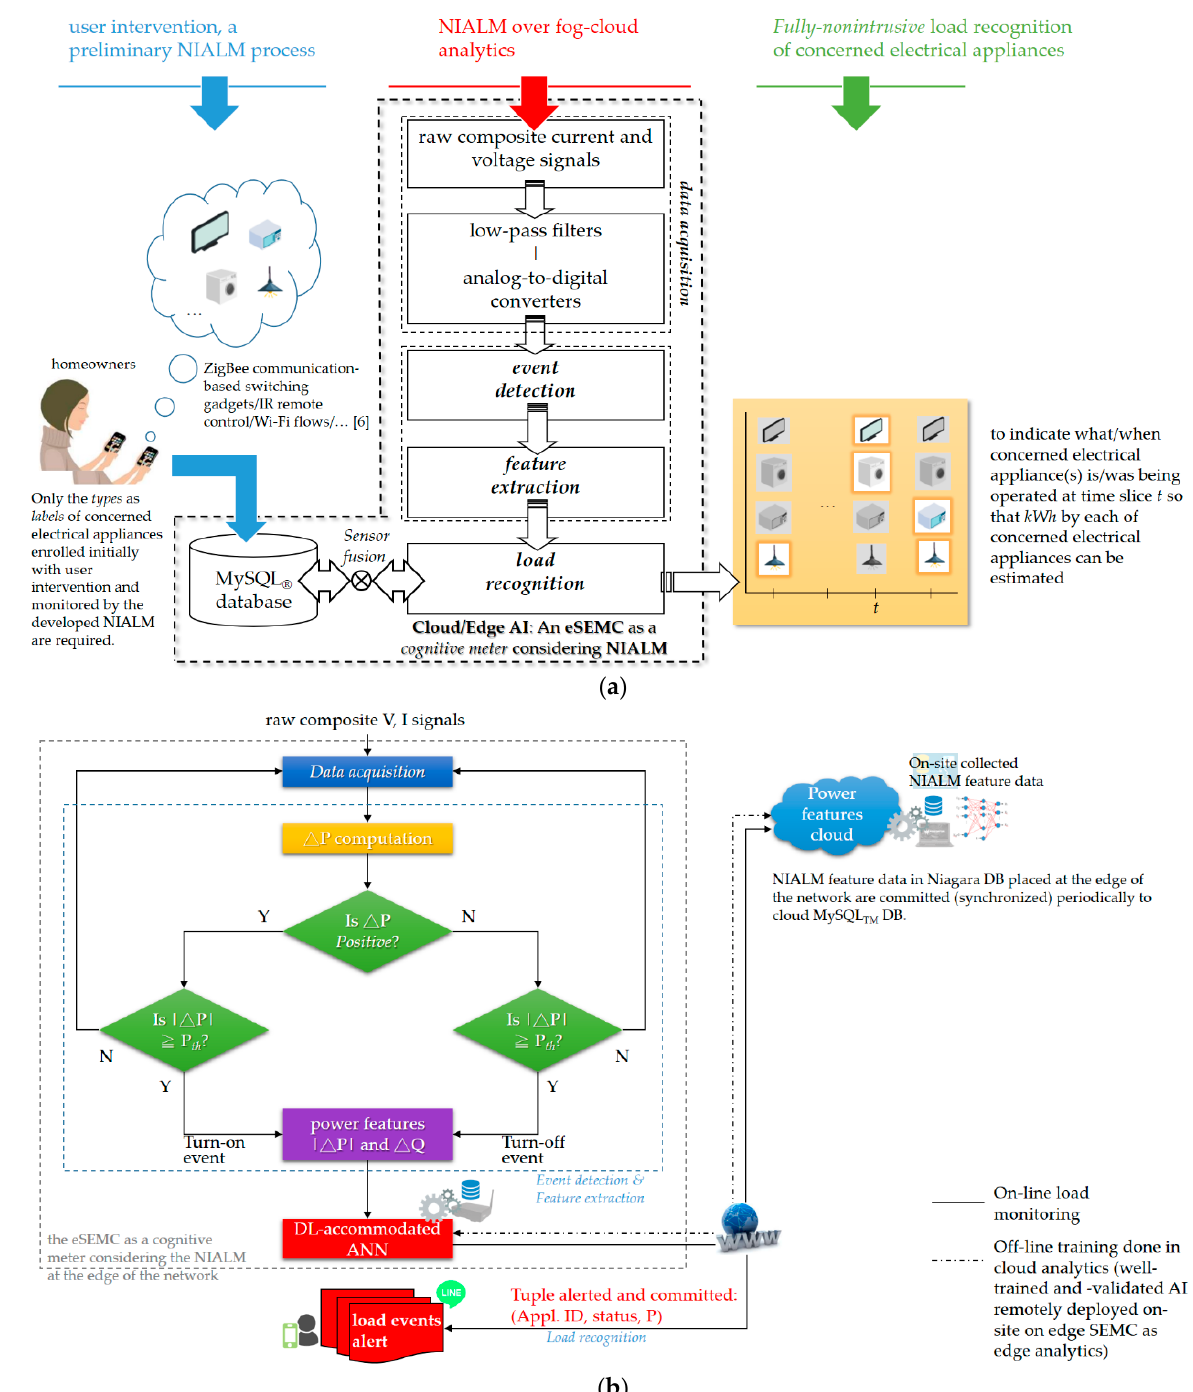
Figure 5. Investigation of the presented NIALM approach: ( a ) Pipeline of the two-stage NIALM, in simple terms, not requiring a one-time intrusive period for the preliminary NIALM process [6]; ( b ) the two-stage NIALM, based on the Niagara Framework ® , over fog-cloud computing.